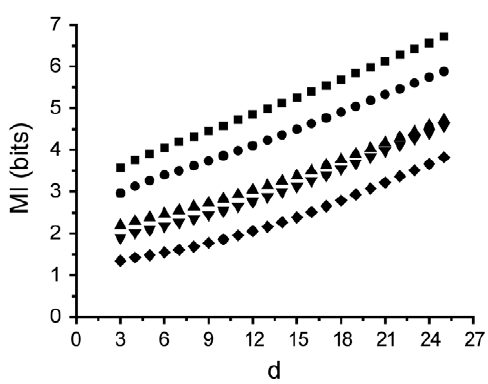
Figure 5. MI as a function of d for the weather stations with varying latitudinal